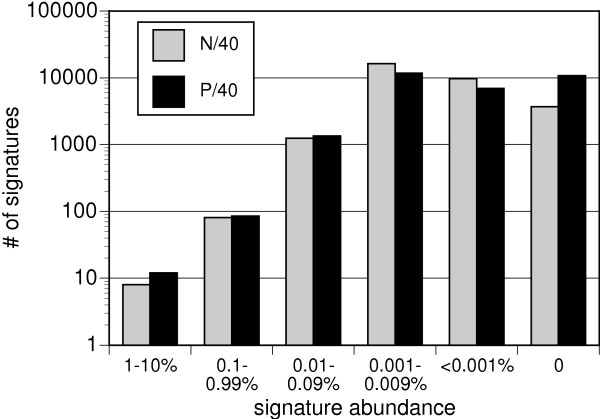
Signature abundance distributions. The abundance of each signature is given as a percentage of total signatures in the N/40 (grey bars) and P/40 (black bars) libraries. For example, 1% abundance indicates a signature that is present 10,000 times in each 1,000,000 sequences (10,000 tpm).